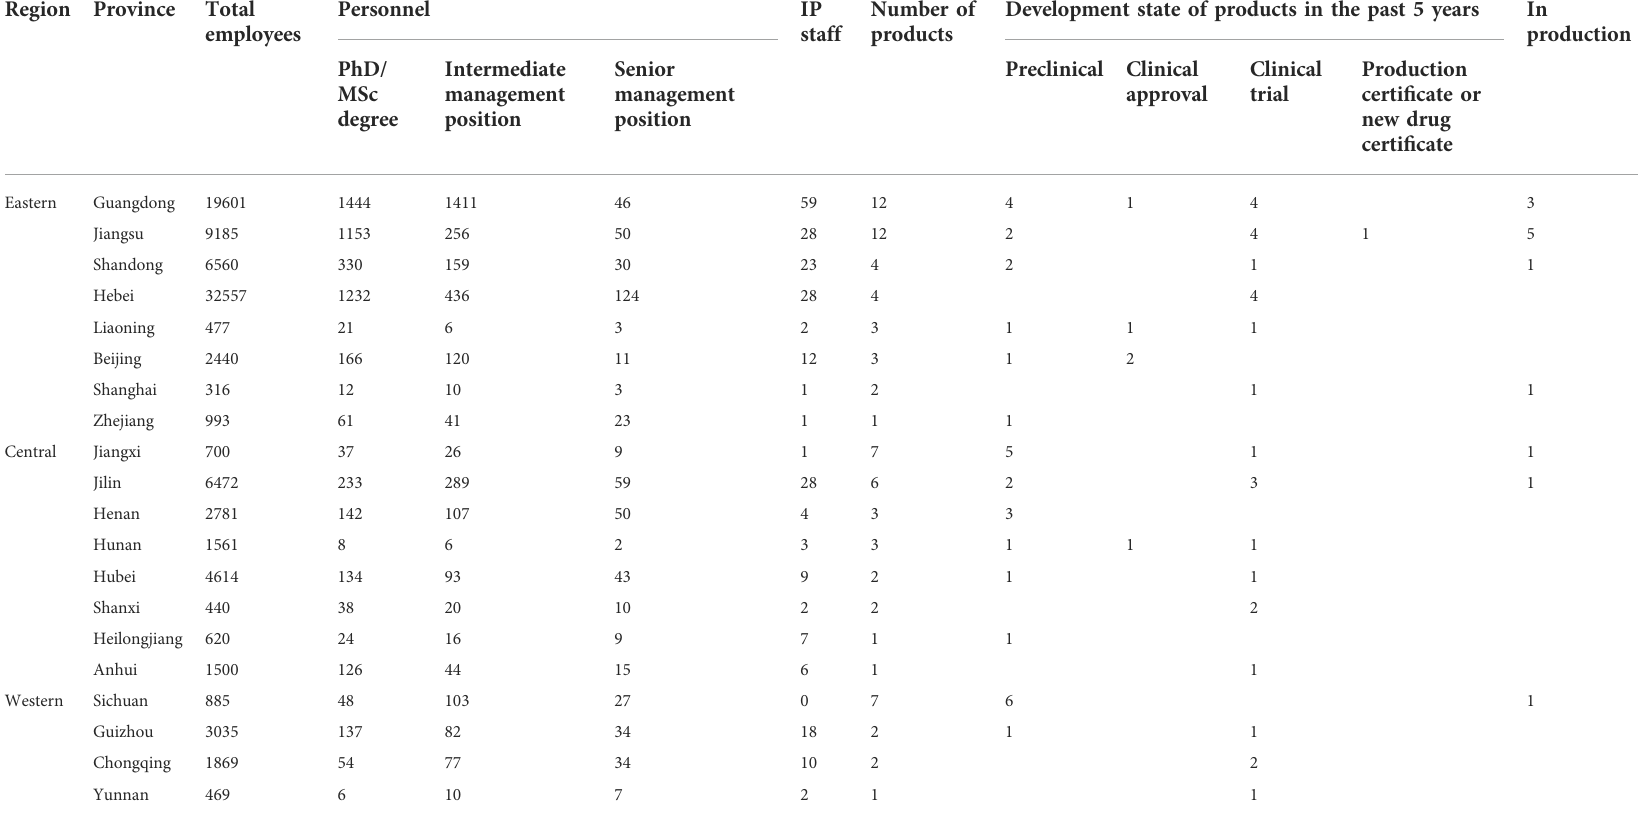
TABLE 2 Distribution of pharmaceutical personnel and the level of development of products according to provinces in China. Region Province